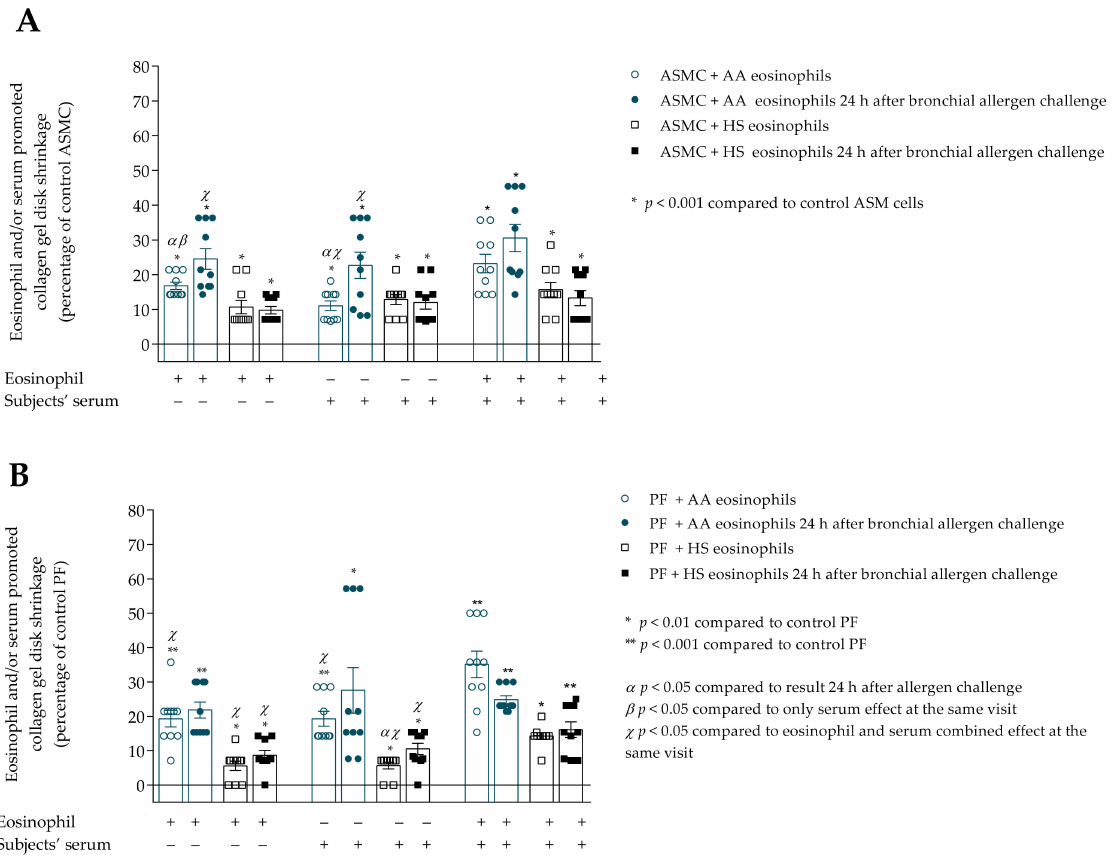
Figure 8. ( A )–Contraction of collagen gel disk with ASMC after incubation with eosinophils and/or subjects’ serum 24 h after bronchial allergen challenge with D. pteronyssinus; ( B )–Contraction of collagen gel disk with PF after incubation with eosinophils and/or subjects’ serum 24 h after bronchial allergen challenge with D. pteronyssinus allergen. Data presented as a percentage of control ASMC that were not incubated with eosinophils. Added blood serum of each investigated subject to individual combined cultures: 2% v / v . ASMC—airway smooth muscle cells; HS—healthy subject; AA—allergic asthma; PF—pulmonary fibroblast. α — p < 0.05 compared to results 24h after allergen challenge; β — p < 0.05 compared to the only serum effect at the same visit; χ — p < 0.05 compared to the eosinophil and serum combined effect at the same visit; A— * p < 0.001 compared to control ASMC; B—* p < 0.01 compared to control PF; ** p < 0.001 compared to control PF. AA n = 10; HS n = 10. Statistical analysis within one study group—Friedman test for multiple comparison within the group and the post hoc Wilcoxon matched-pairs signed-rank two-sided test (dependent data). Significant differences of ASMC-induced collagen gel shrinkage were found in AA group 24 h after bronchial allergen challenge by Friedman test, χ 2 = 12.96, df = 2, p = 0.0005. Significant differences of PF-induced collagen gel shrinkage were found in HS group 24 h after bronchial allergen challenge by Friedman test, χ 2 = 9.929, df = 2, p = 0.0038. The results from Figure 5A,B of AA and HS patients were re-used as the baseline (before allergen challenge)